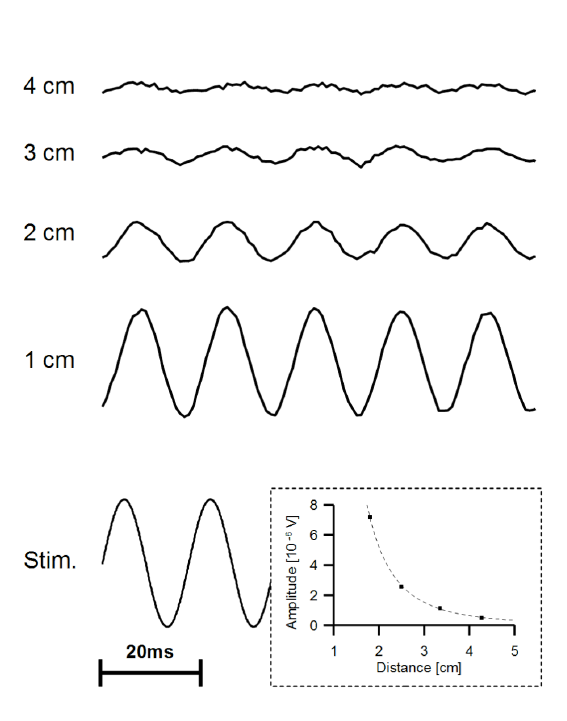
Figure 2: A typical AN response to a dipole flow field. The sinusoidal voltage used to drive the mini-shaker (bottom left) and the voltage output of the AN exposed to the vibrating sphere (top 4 traces) is shown. Distances between the ALLC and the vibrating sphere were 1, 2, 3 and 4 cm. The voltage output of the AN is plotted on the same scale. Inset: Voltage output of the AN as a function of sphere to pore distance. The fitting function (dashed line) is f(x) = 42.66 x − 3.03 . This indicates a third order decrease of sensor output with increasing sphere distance.